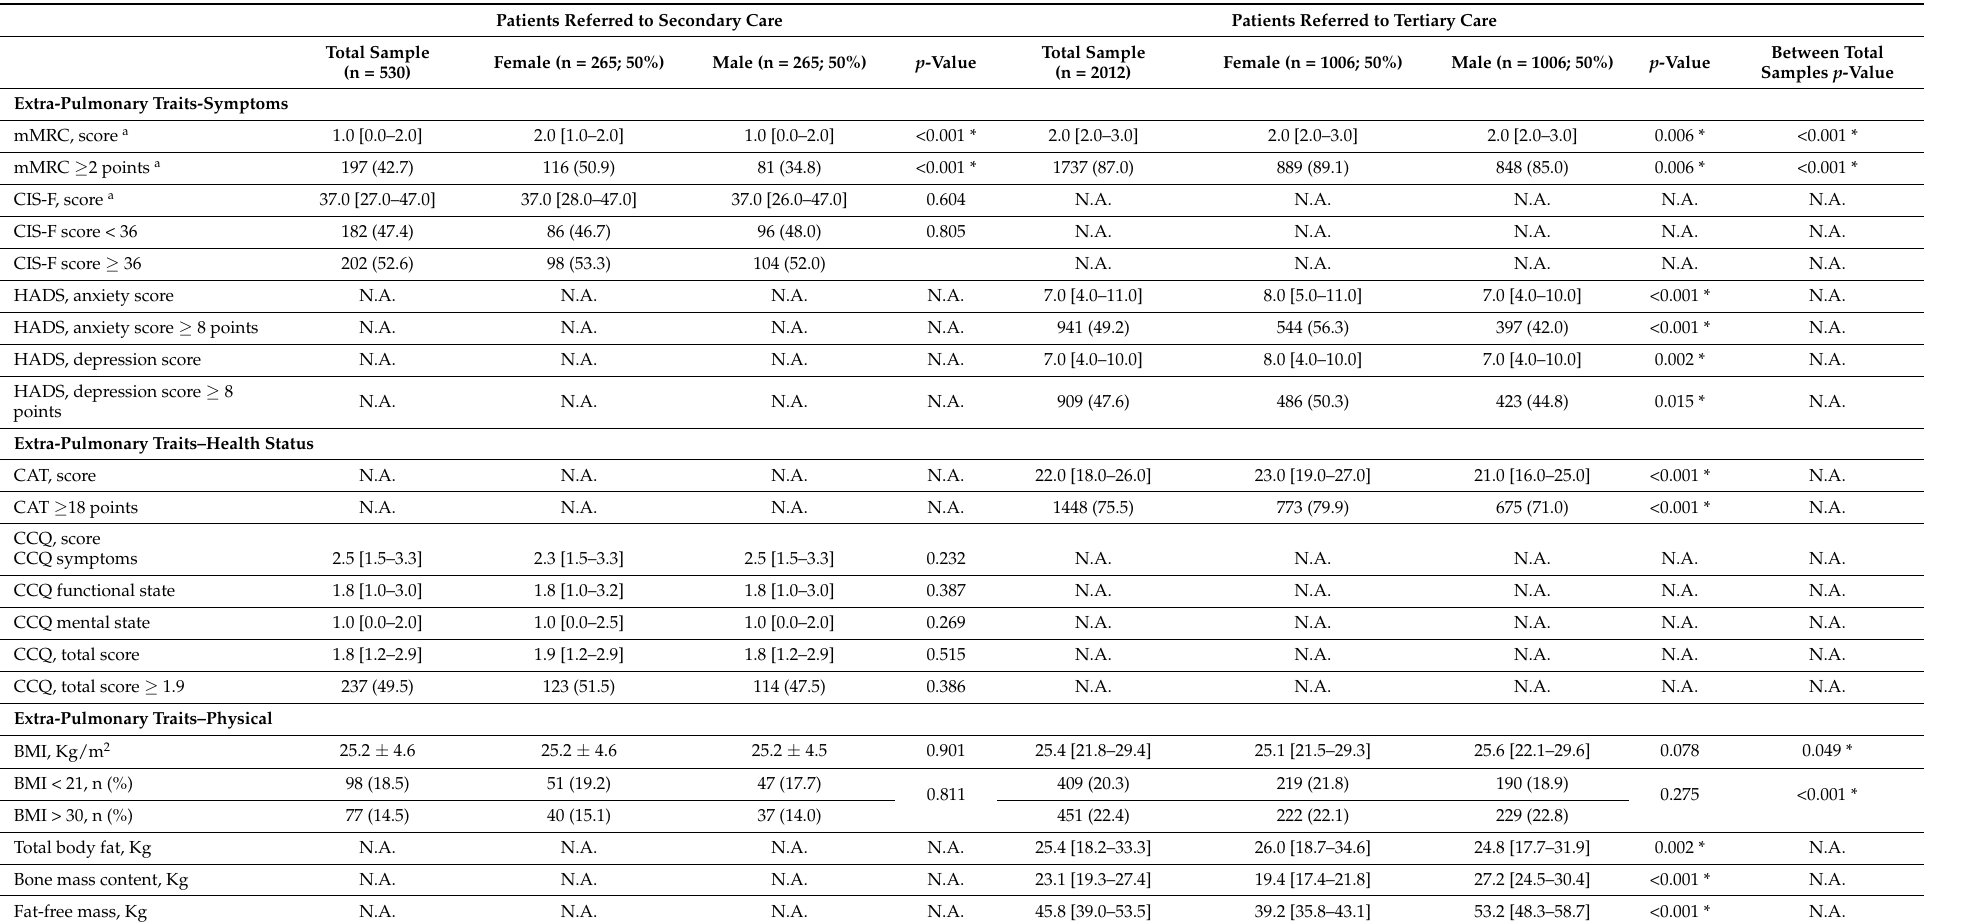
Table 3. Extra-pulmonary and behavioural traits of female and male patients with chronic obstructive pulmonary disease (COPD) and comparison between secondary care (n = 530) and tertiary care samples (n =